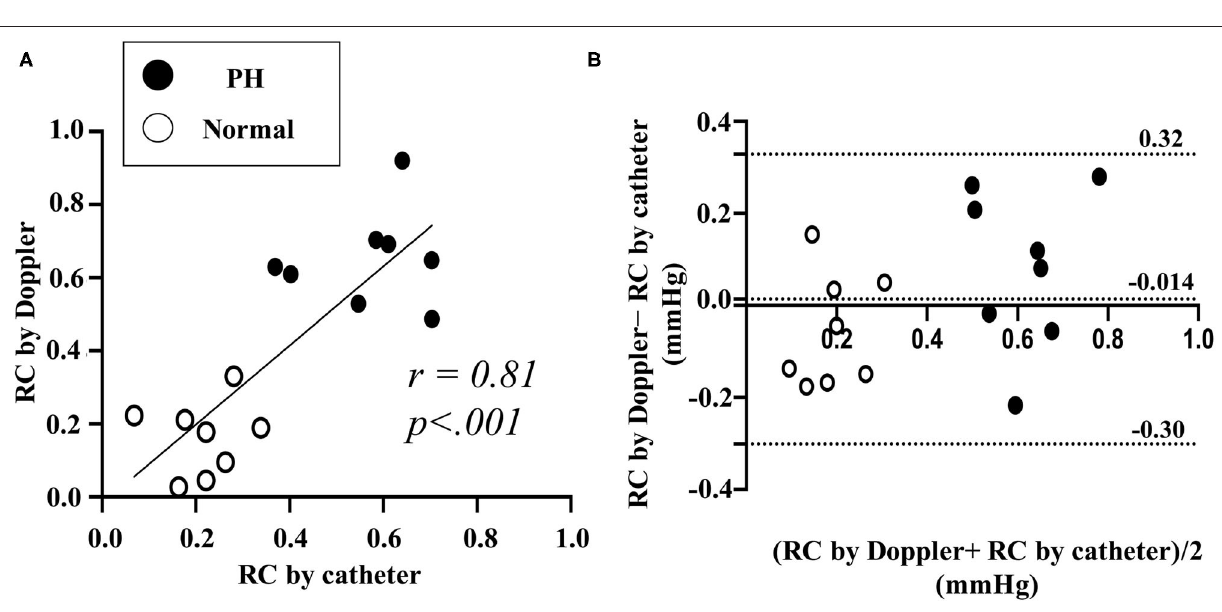
increased to maintain cardiac output in the face of increased pulmonary artery afterload, and Pb is also increased due to differences in the vascular impedance between the proximal and distal vascular system (10). Patients suspected with PH were significantly higher Pf, Pb, and RC values compared to those